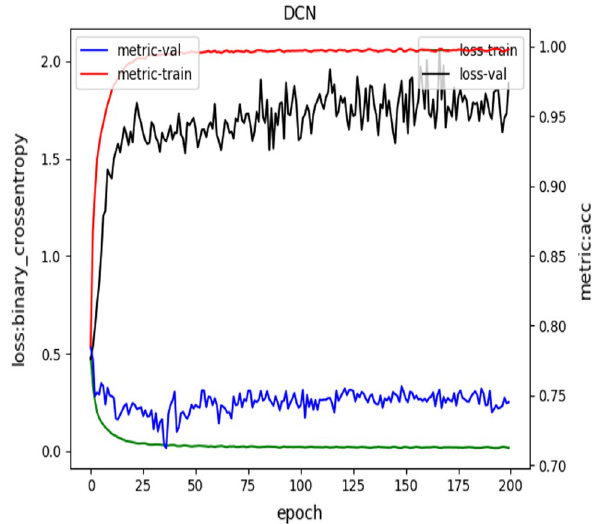
Fig. 9 A UC and Logloss of DCN algorithm